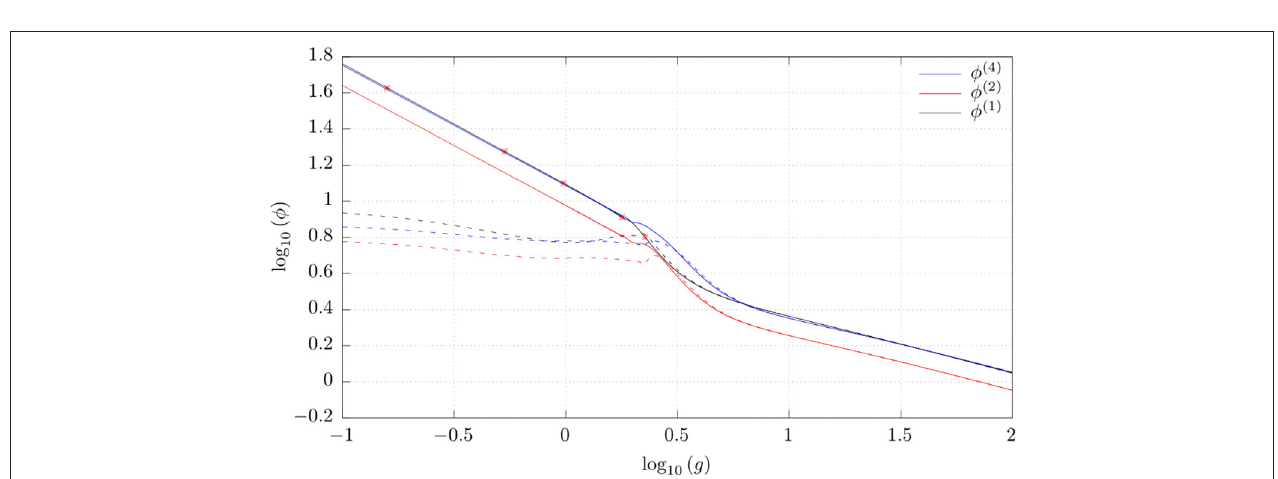
FIGURE 3 | Samples of the total cross sections φ ( n ) calculated for both Lennard-Jones (solid lines) and Lennard-Jones/spline (dashed lines) particles, as a function of the relative speed g . The stars are tabulated values of φ (1) for the LJ potential from